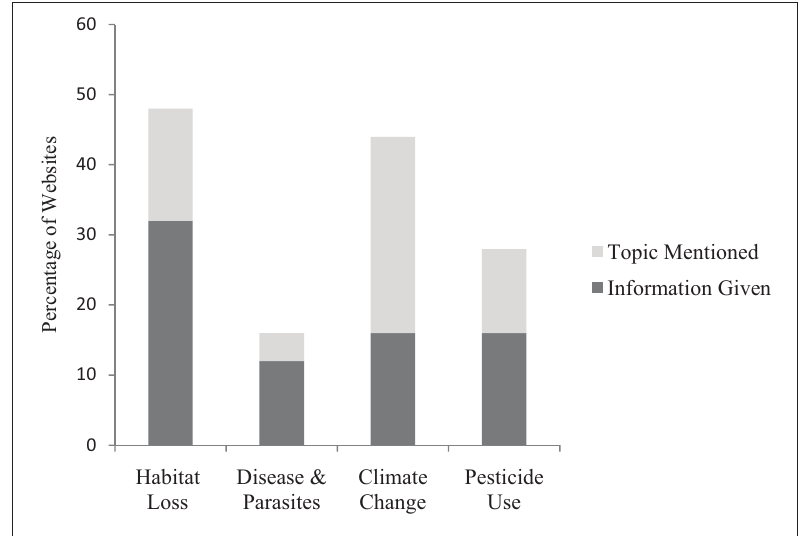
Figure 2: Percentage of project websites providing information on or mentioning butterfly conservation threats, n =